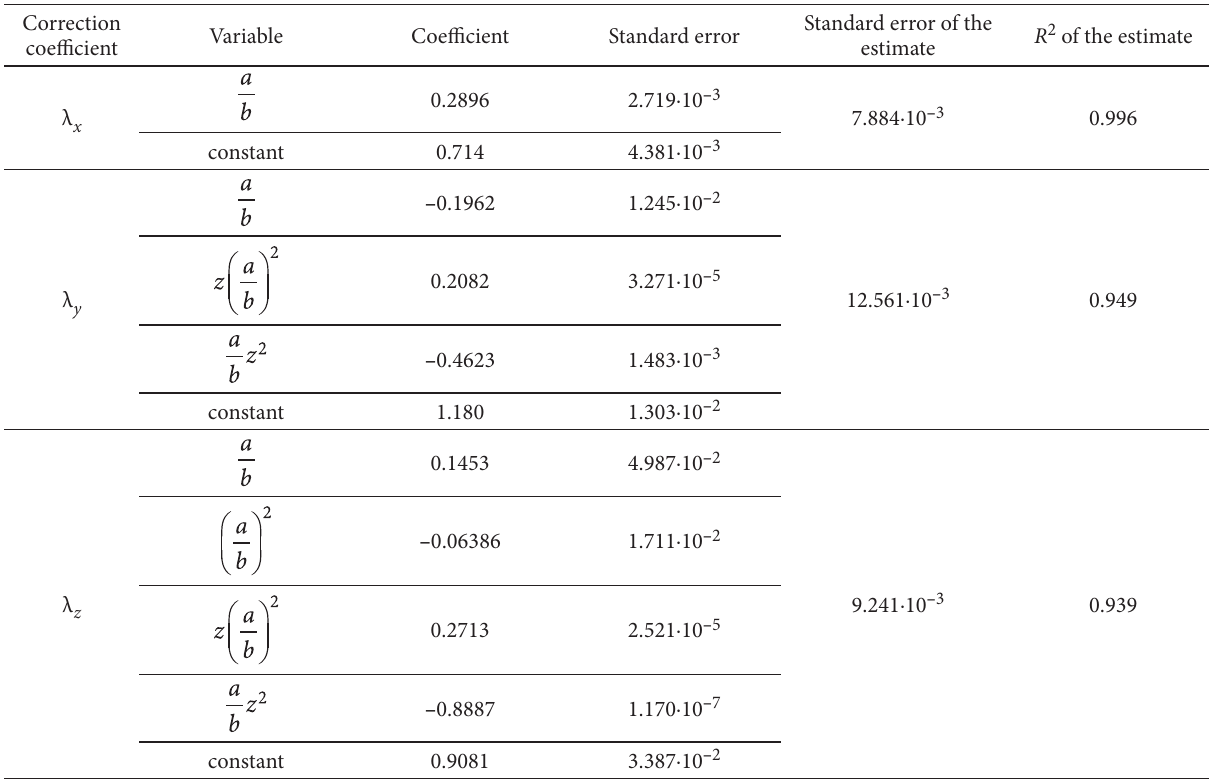
Table 2. Statistical parameters of correction coefficients λ x , λ y , λ